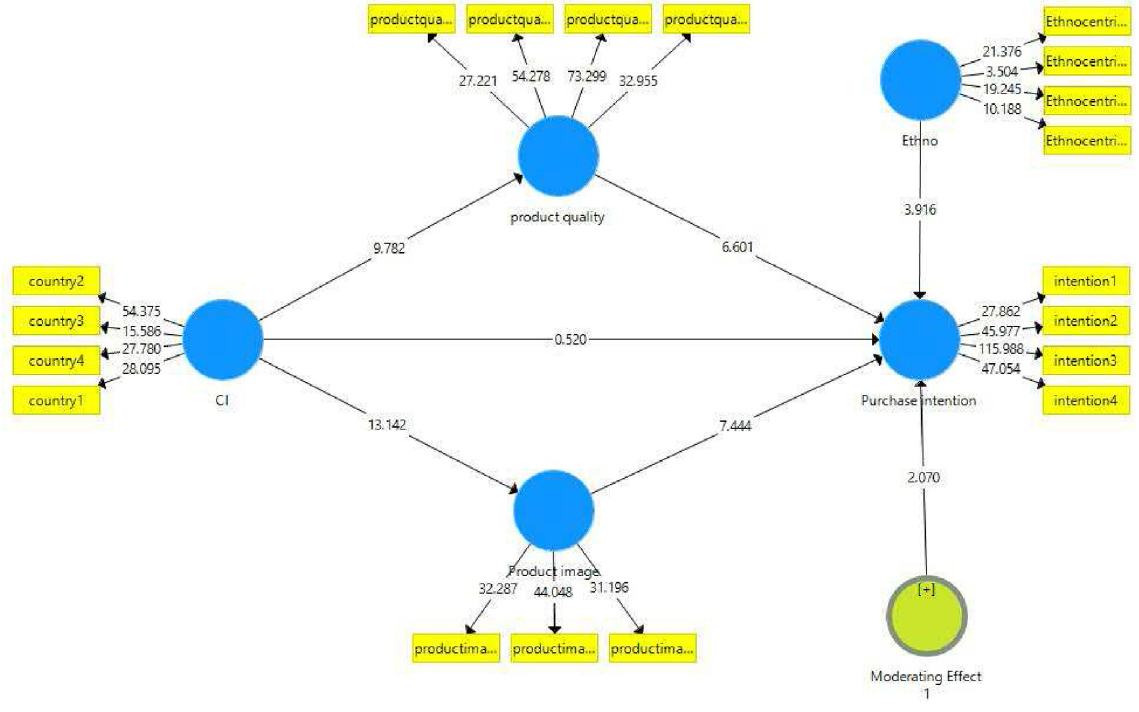
Fig. 2. Smart-PLS t-test